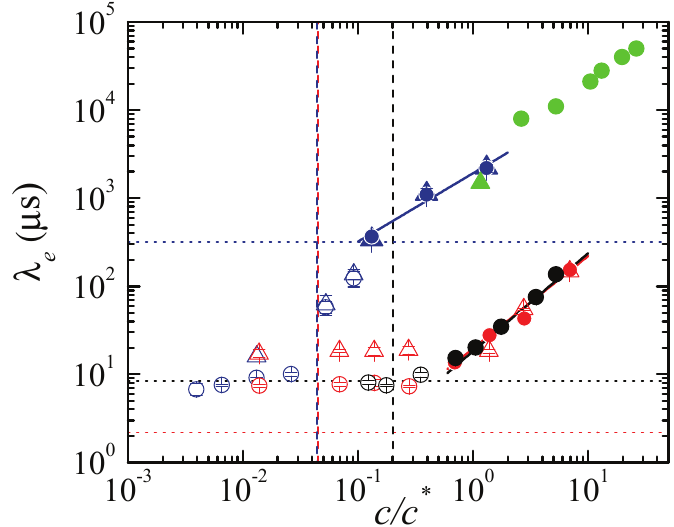
Figure 9. Mean values of the measured extensional relaxation times λ e as a function of the polymer reduced concentration c / c ∗ for PVP (black symbols), PEO100K (red symbols) and PEO2M (blue symbols), respectively. The solid and open symbols correspond to true and discarded values, respectively. The circles and triangles correspond to the results measured with R = 115 and 205 µ m, respectively. The error bars indicate the standard deviations. For most of the solid symbols, these bars are not appreciated because they are smaller than the symbol size. The black, red and blue solid lines are the fits (1) to the experimental data within the interval c / c ∗ > 0.6 for PVP and PEO100K and c / c ∗ > 0.1 for PEO2M. The black, red and blue horizontal dotted lines indicate the longest Zimm relaxation time (2) for PVP, PEO100K, and PEO2M respectively. The black, red and blue vertical dashed lines indicate the values of c low for PVP, PEO100K and PEO2M, respectively (the red and blue lines practically overlap). The green triangles and circles are data for PEO2M obtained from Refs. [17,18],